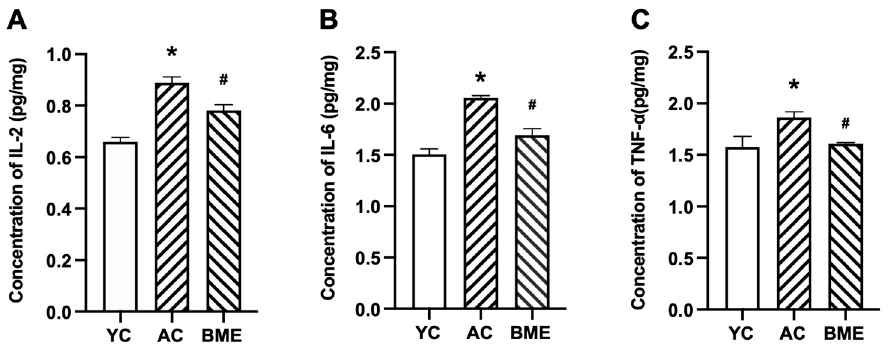
Figure 3. Effects of BME on the expression levels of the cytokines ( A ) IL-2, ( B ) IL-6, and ( C ) TNF- α in mouse brain tissues were detected using ELISA. All results are expressed as means ± SEMs ( n = 6). * p < 0.05 versus YC group, # p < 0.05 versus AC group. AC: aged control, BME: blueberry–mulberry extract, YC: young control.